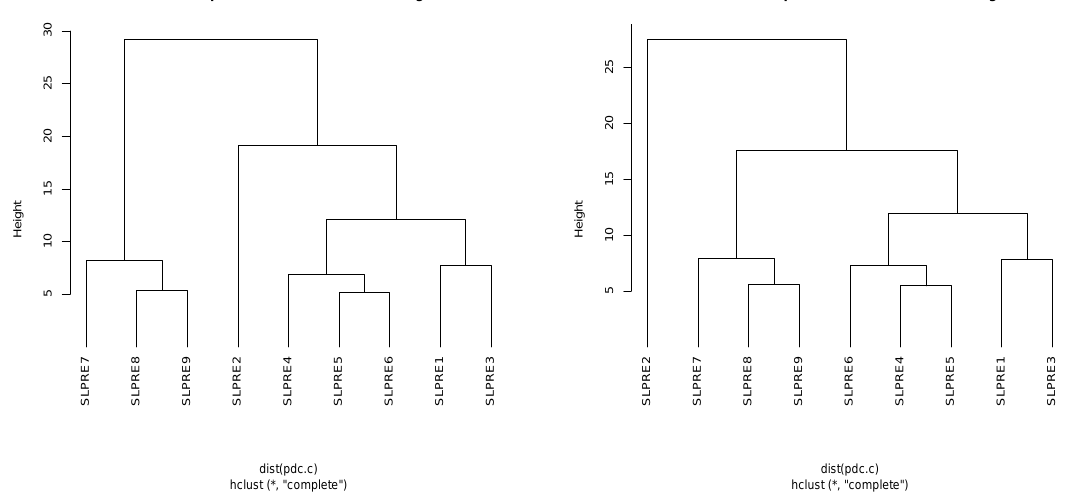
Figure 4. Dendograms of the right sole after the walk: Diabetics ( left ) and nondiabetics ( right ). SLPRE i represents the temperature for left sole before the walk for index i